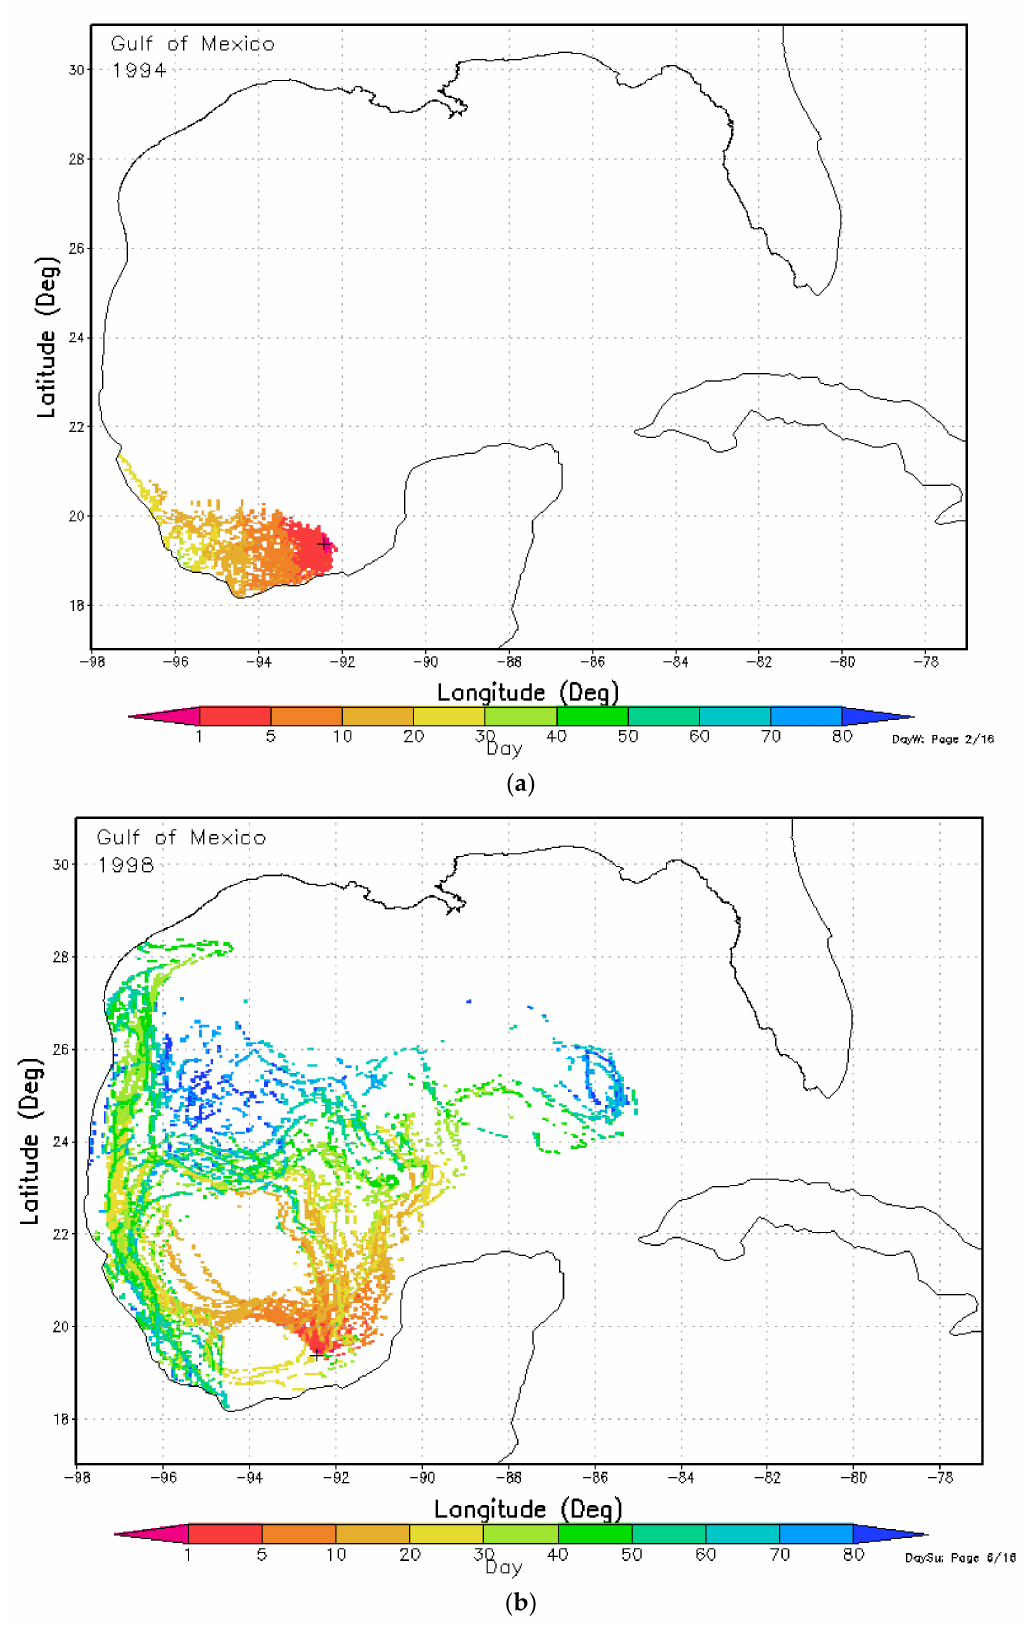
Figure 9. ( a ) Time of contact with oil spilled from the Ixtoc I location (shown with a + sign) in the winter (January–March) of 1994. ( b ) Time of contact with oil spilled from the Ixtoc I location (shown with a + sign) in the summer (July–September) of